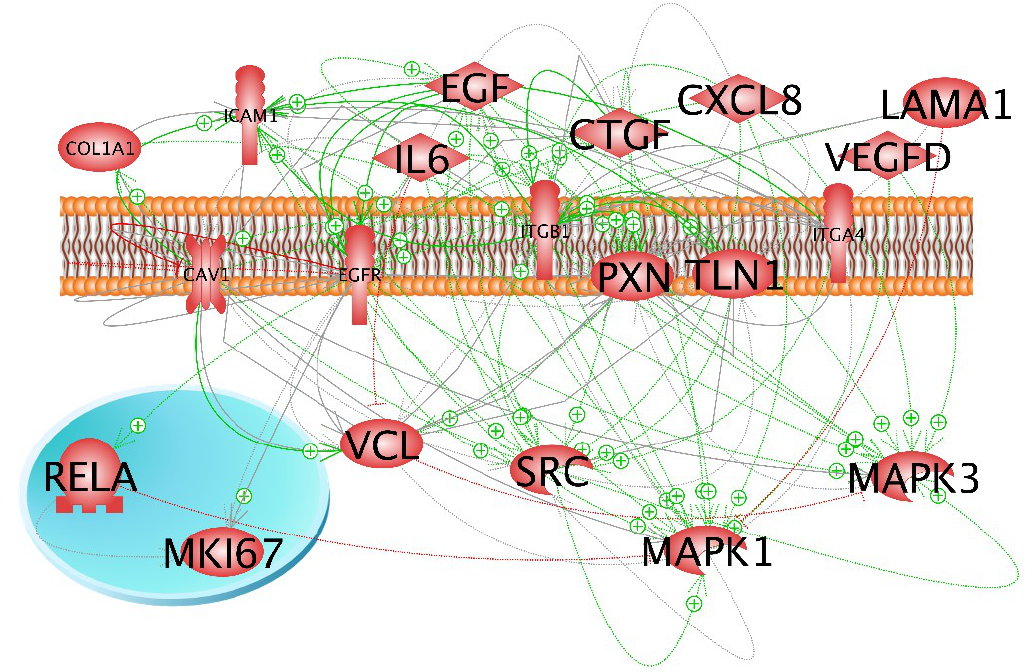
Figure 1. Localisation and interaction of the gene products selected for quantitative real-time polymerase chain reaction analysis. The blue circle indicates the nucleus, and the orange structure shows the membrane. Green arrows indicate stimulation and red lines with a terminal crossbar show inhibition. Grey arrows indicate interactions with an unknown effect. Grey lines show protein–protein complex formation. Solid arrows indicate regulation by direct interaction and dashed arrows indicate indirect regulation via other cell components.